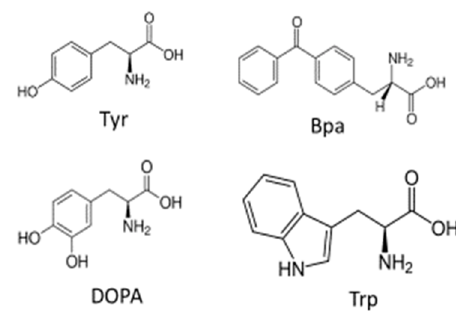
Figure 5. Structures of tyrosine (Tyr), 3,4-dihydoxyphenylanine (DOPA), tryptophan (Trp), and 4- benzoylphenylalanine (BPA).